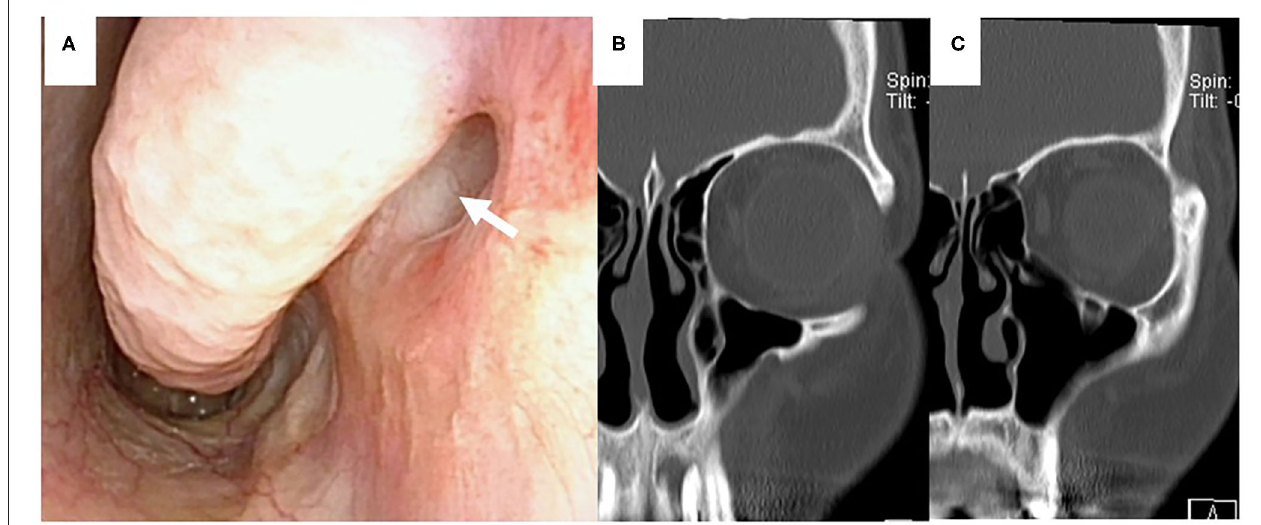
FIGURE 5 | Post-operative findings 6 months after the operation. (A) Fiberscopic findings showed that the nasolacrimal orifice could be observed in the inferior meatus (white arrow). (B,C) Coronal CT scan findings showed the inferior meatus and patency of the nasolacrimal duct and orifice.